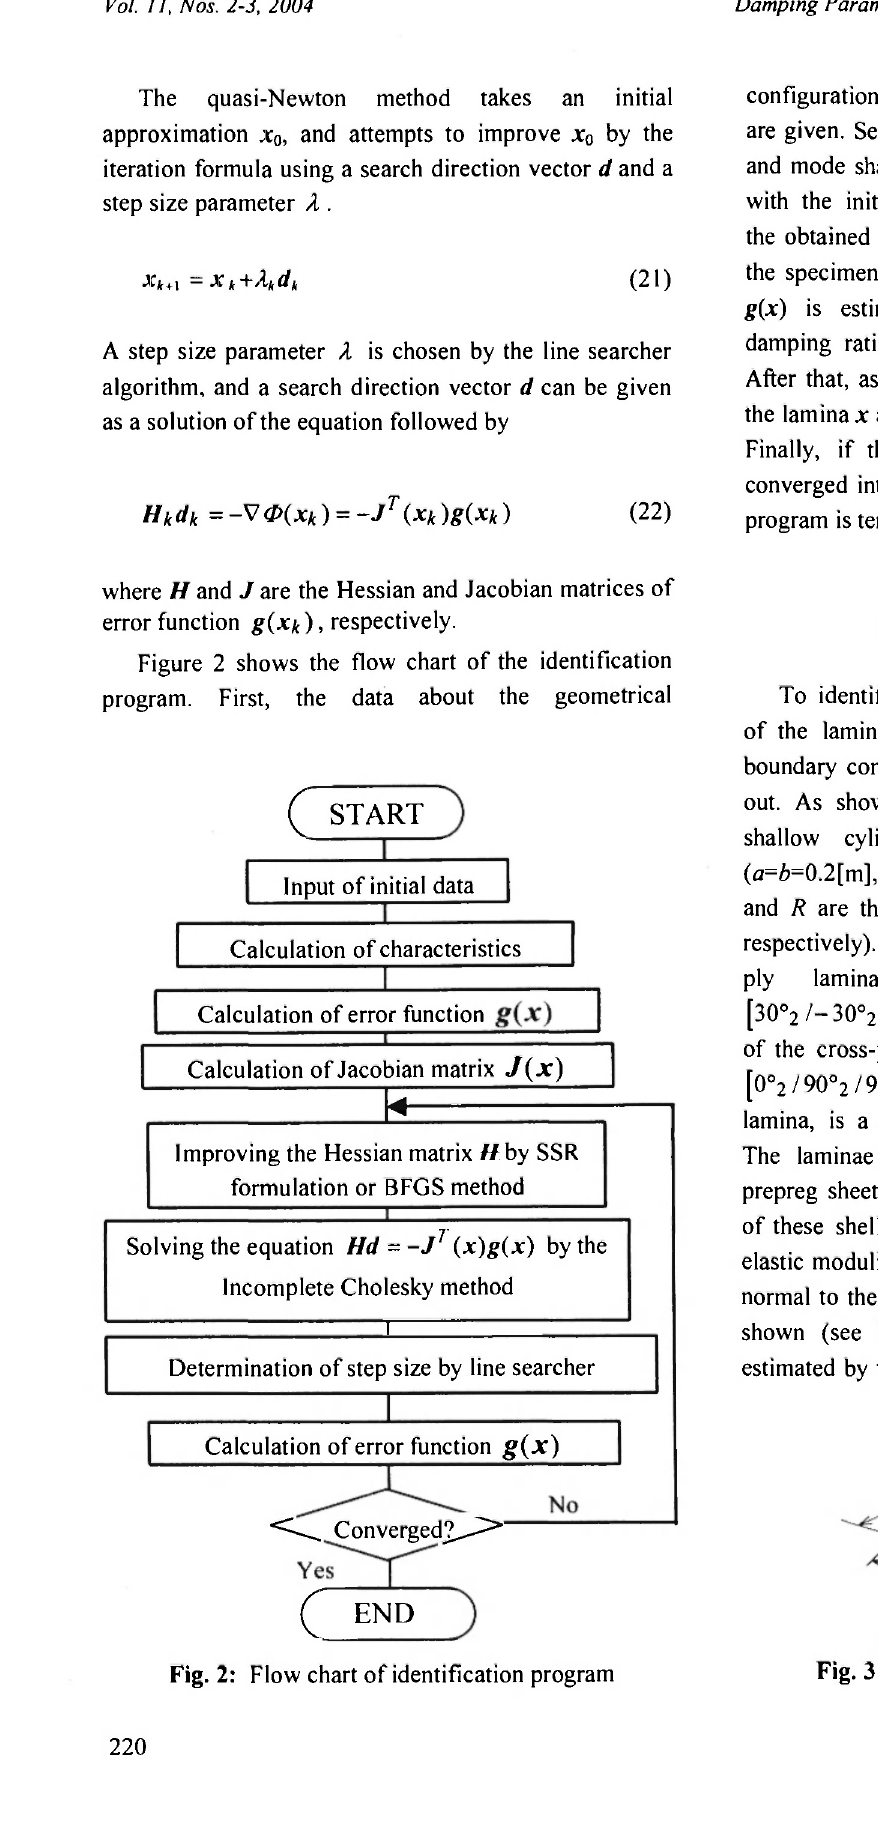
Fig. 2: Flow chart of identification program 220